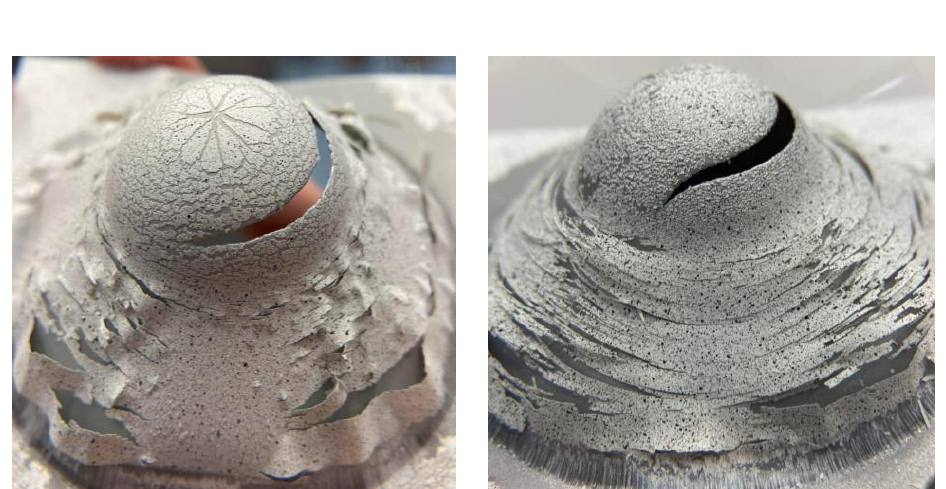
Figure 17. Separated paint after forming as shown for P7/SC4, P4/SC1. Table 14. Measurement results of durability tests.